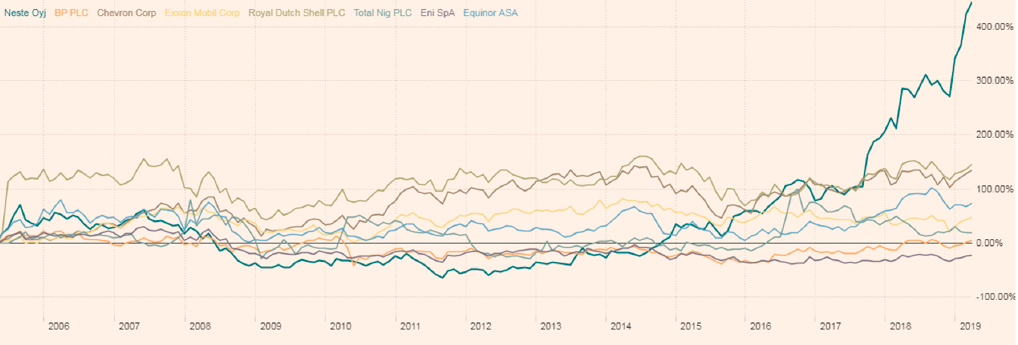
Figure 12. Share price development of Neste and oil super majors. Source: [44].